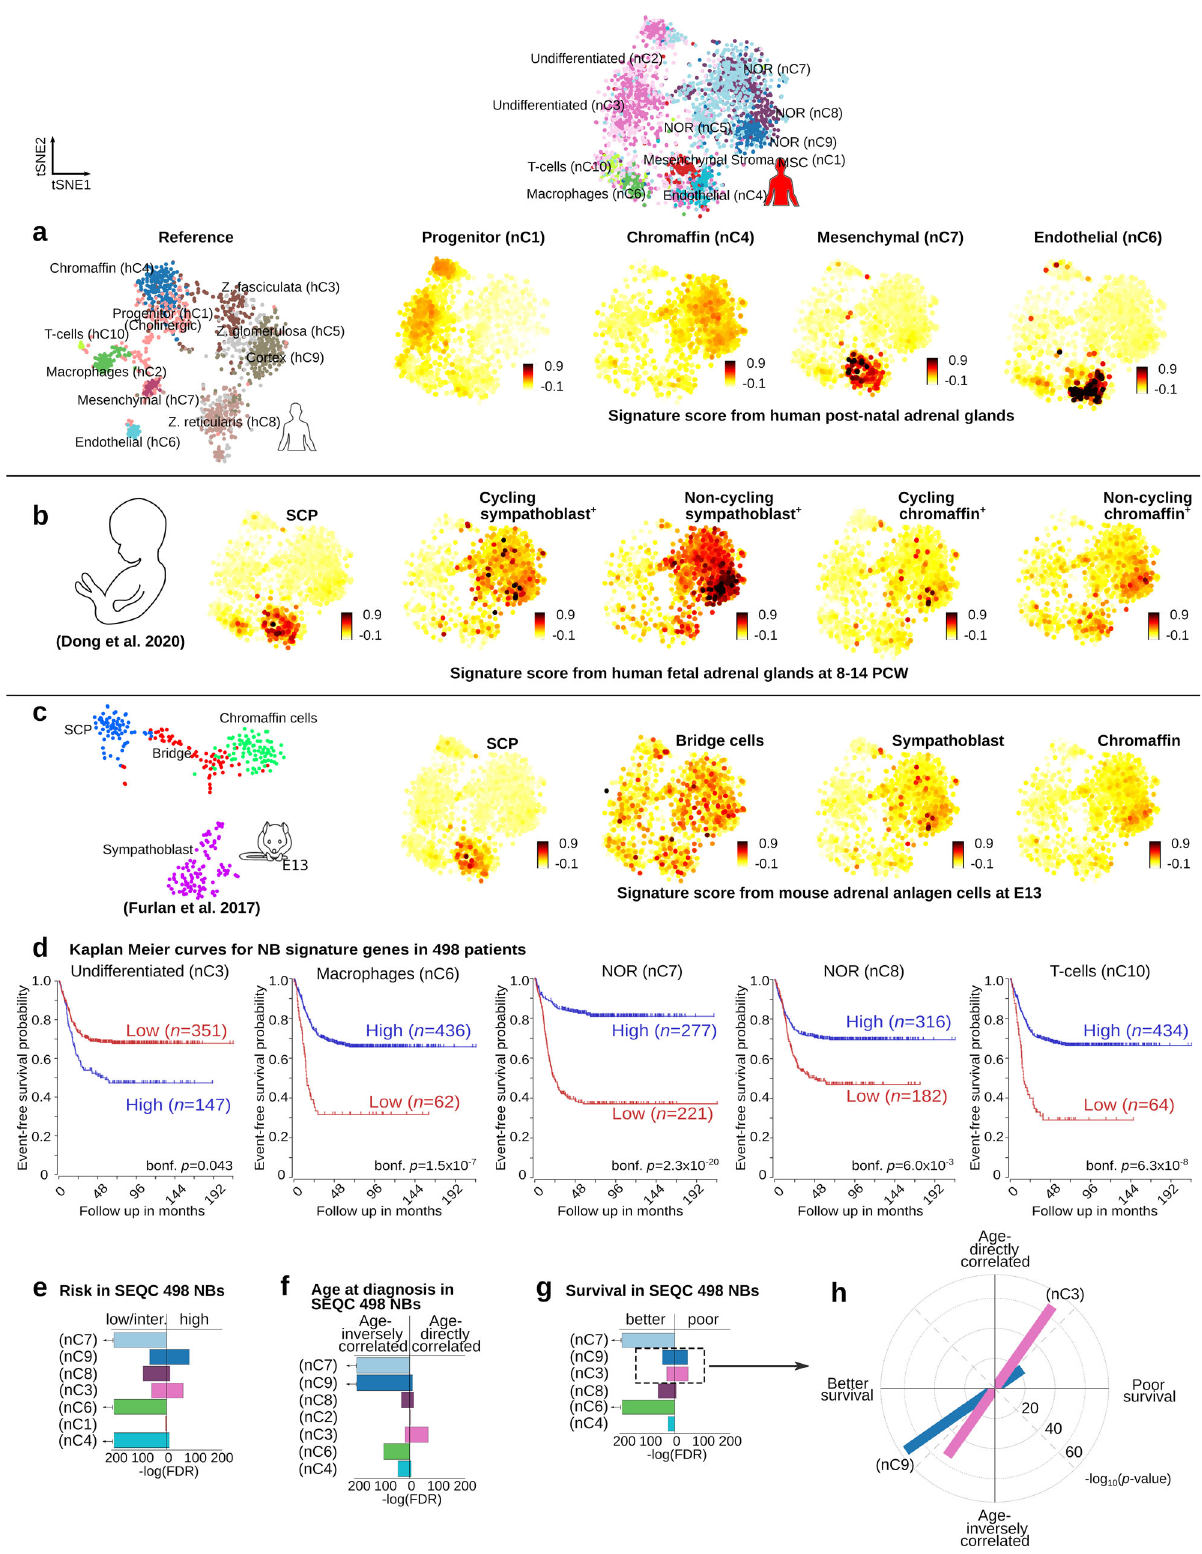
statistical analysis of these Euclidean distances (Fig. 7d) indicated that (1) SCPs, glial, endothelial, and mesenchymal cells from human and mouse adult and embryonic E12 – E13 populations share a similar transcriptional pro fi le, (2) human adrenal progenitor cluster hC1 resemble that of the neuroblastoma undifferentiated populations nC2 and nC3, and (3) chromaf fi